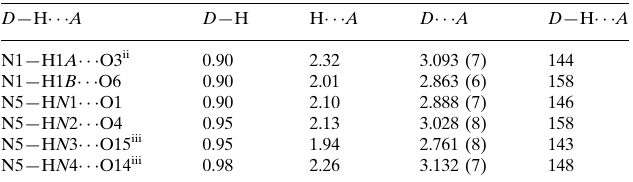
Hydrogen-bond geometry (A˚ , (cid:2)